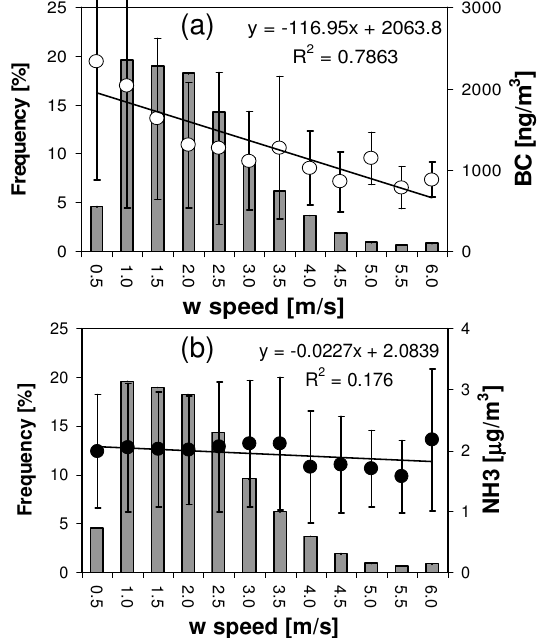
Fig. 9. Correlation between the frequency distribution (%) of scalar wind velocity (ms − 1 ) and (a) BC concentration and (b) NH 3 con- centrations at